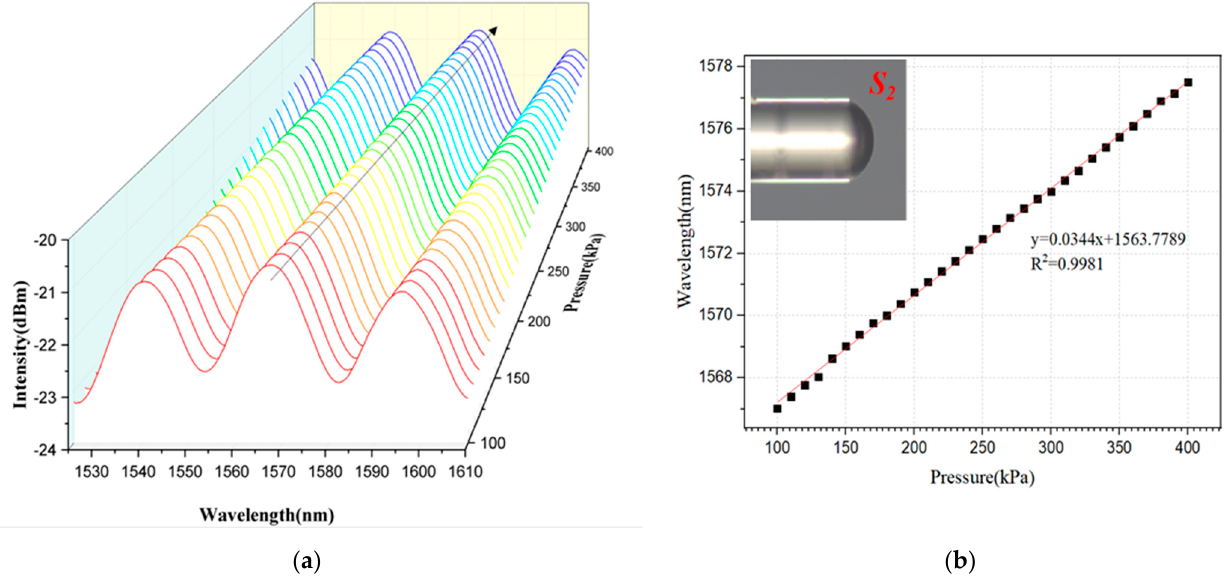
Figure 11. ( a ) The gas pressure (ranging from 100 to 400 kPa, in strides of 10 kPa) response interference spectrum of S 2 (Ecoflex0030/PDMS); and ( b ) pressure sensitivity of S 2